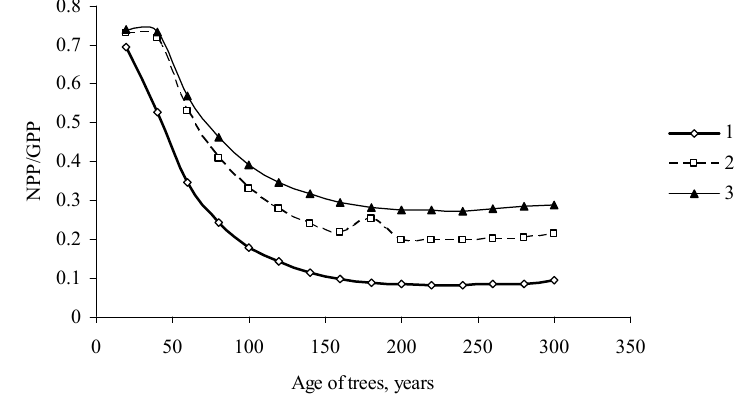
Figure 6. Changes in the effectiveness of photosynthesis in the Scots pine trees as related to the age of the stands ( 1 ) South Siberia; ( 2 ) Middle Siberia; ( 3 ) North Siberia.